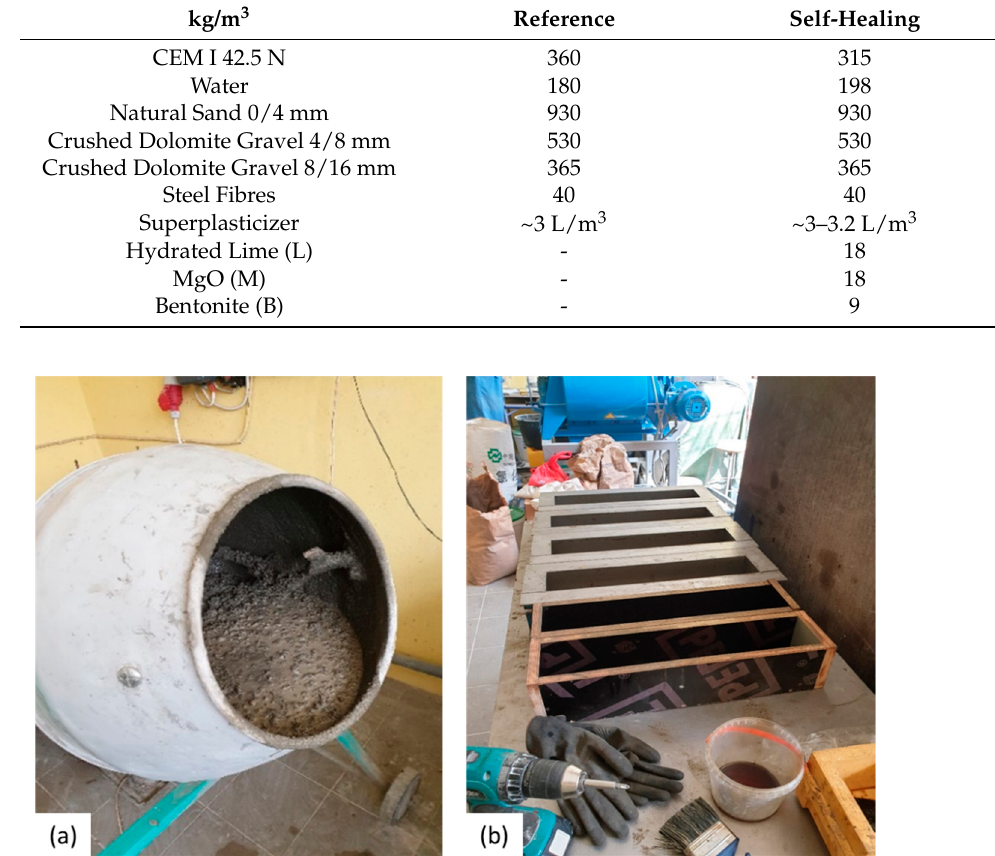
Figure 1. Sample preparation of concrete specimens with mineral additions (( a ) mixing; ( b ) moulds used for